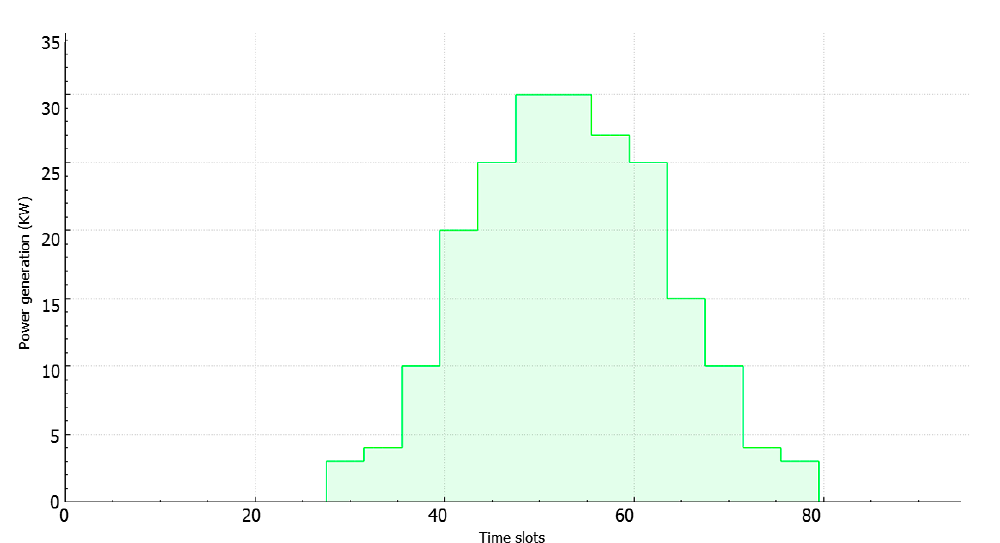
Figure 4. Predicted output power from the photovoltaic panels.